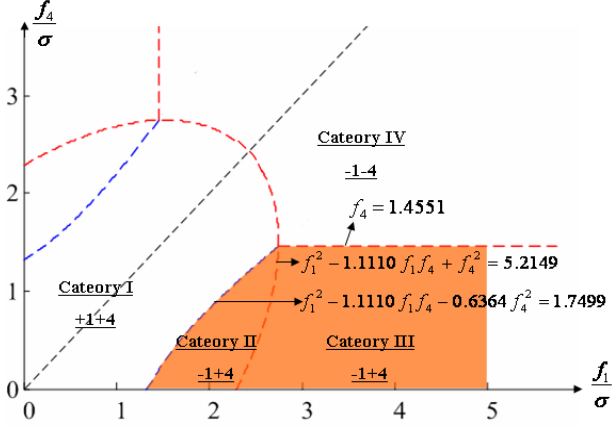
Figure 10. Region of categories I through IV for 1 st and 4 th faulty sensors for configuration 2.